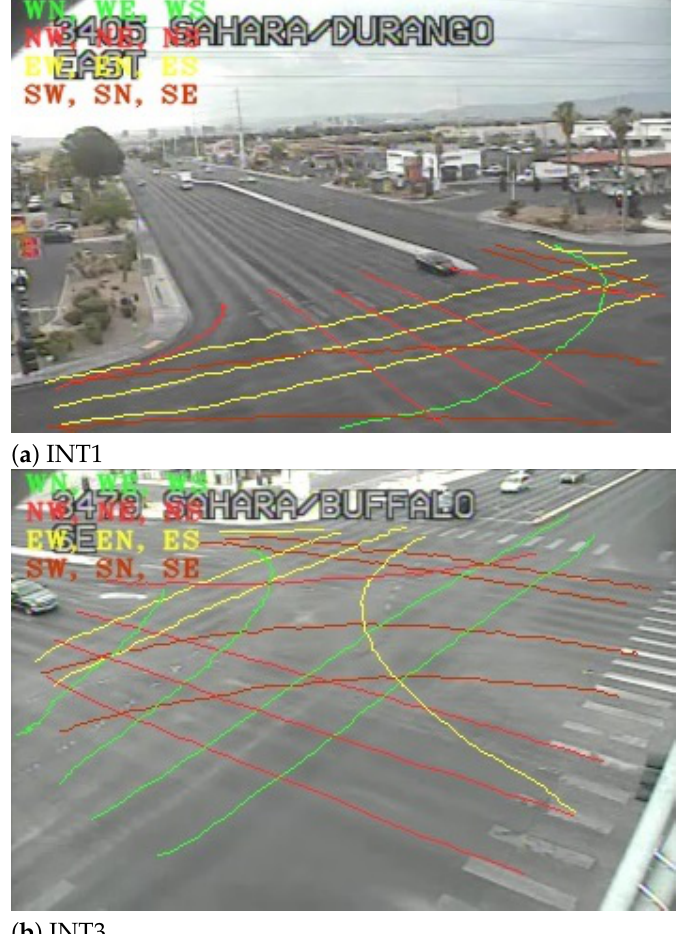
Figure 2. Typical